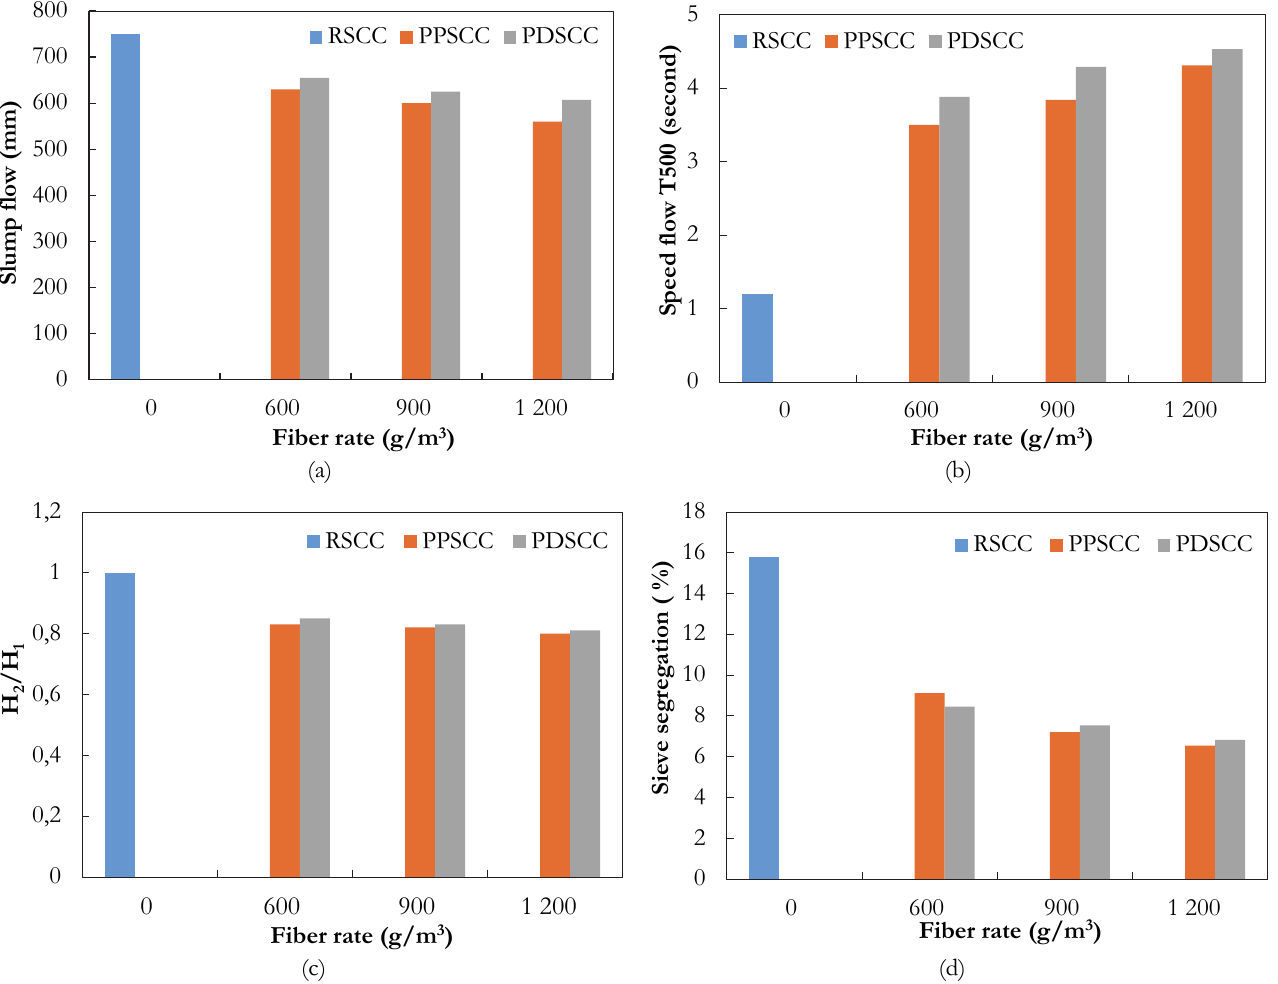
Figure 14: Effect of fiber rate on: (a) Slump flow, (b) speed flow (T500), (c) L-BOX test and (d) segregation resistance. The non-fibered concrete (RSCC) shows no blockage (Fig. 15a). The PPSCC causes a blockage at the level of the steel